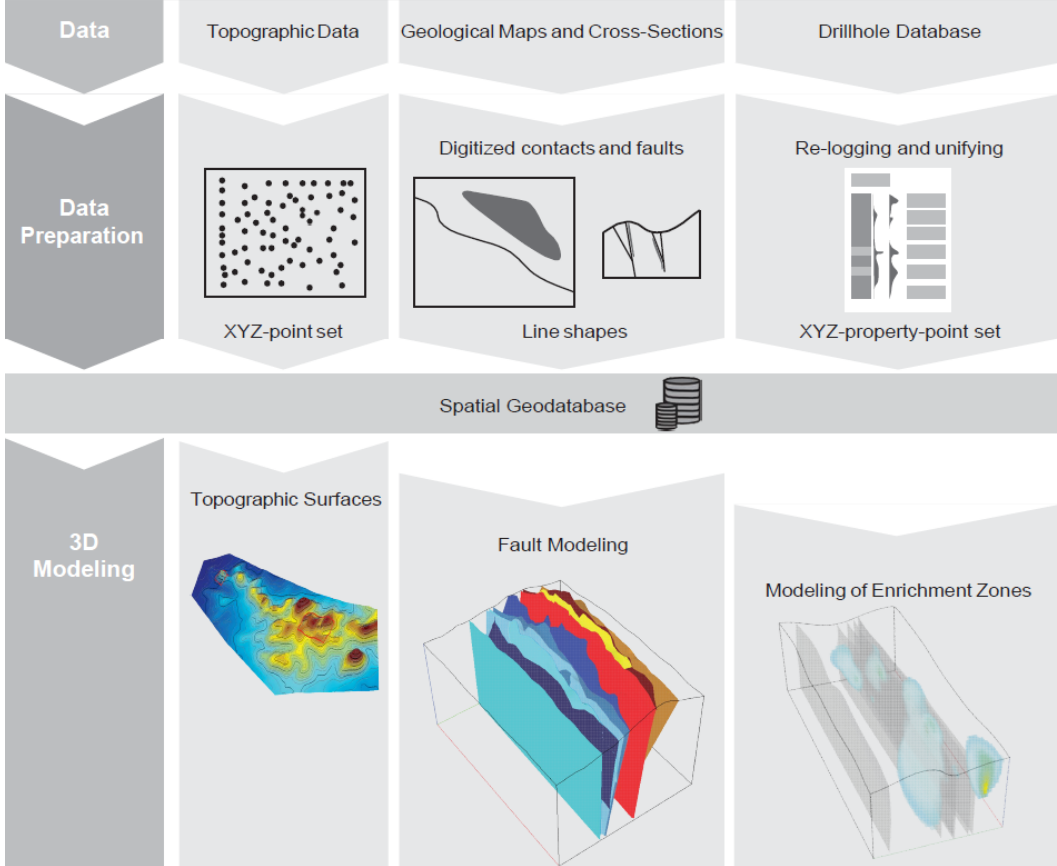
Figure 2. Overview of the processing workflow established to generate the 3D model of the Epembe deposit. See the text for a detailed